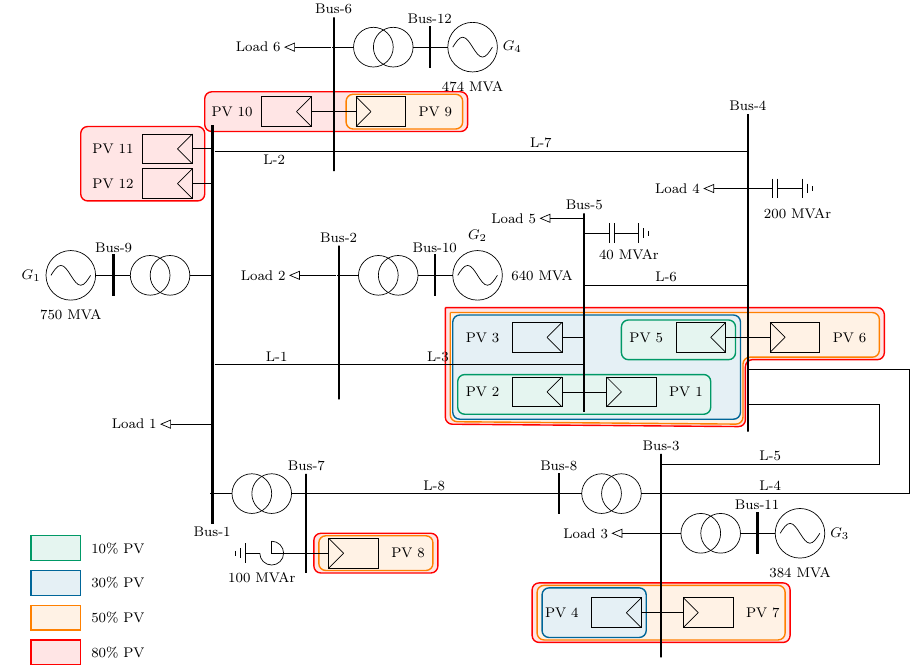
Figure 6. 12-bus test system with different penetration levels of PV